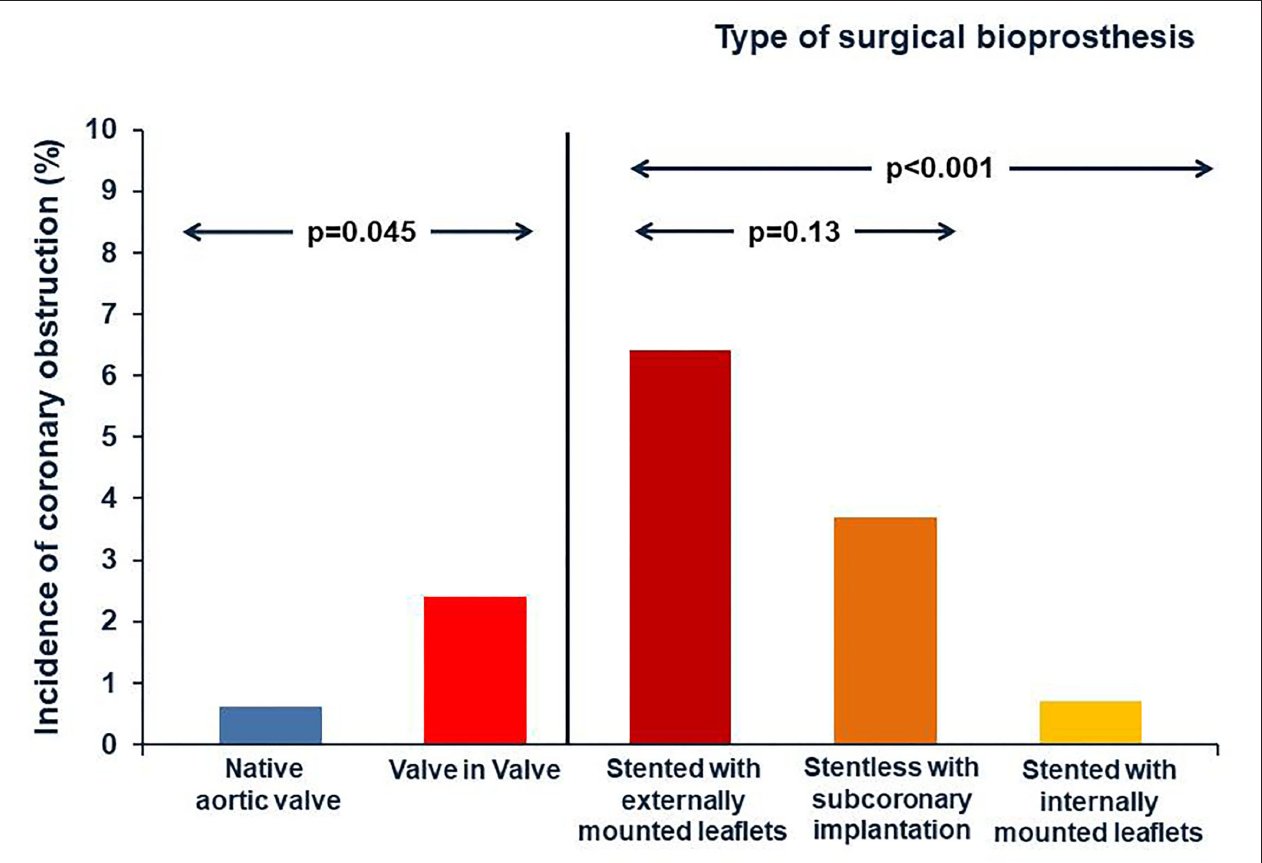
FIGURE 3 | Incidence of coronary obstruction. The incidence of coronary obstruction is four folders greater in TAVI for degenerative bioprosthetic valves compared to TAVI for native aortic valves. The risk of coronary obstruction is also correlated to the type of SHV. Indeed it is highest during VIV TAVI procedures for surgical bioprothesis designs intended to maximize effective aortic orifice area (such as “stented” bioprostheses that have externally mounted leaflets, and “stentless” surgical